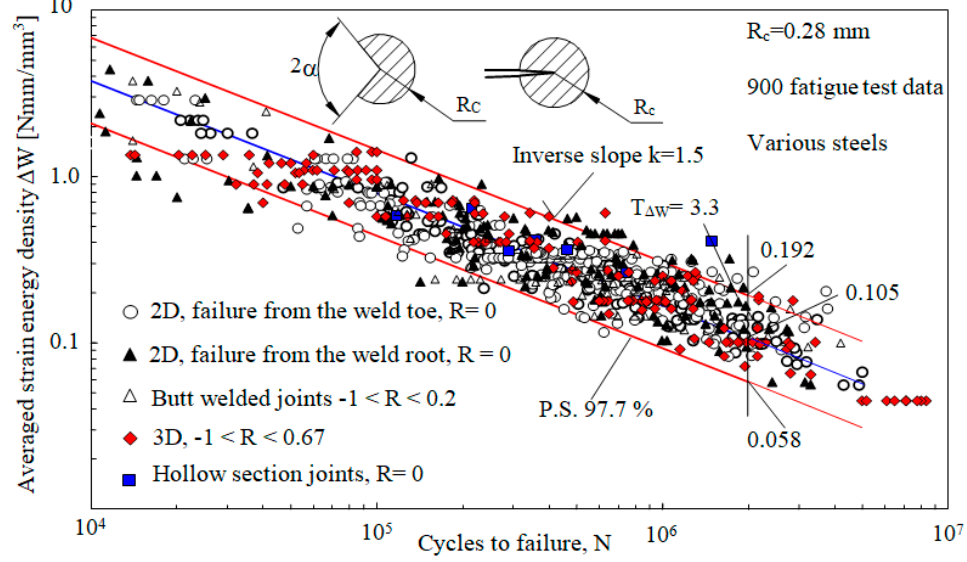
Figure 1. Fatigue behavior of welded joints as a function of the averaged local strain energy density range ∆ W ; R is the nominal load ratio.